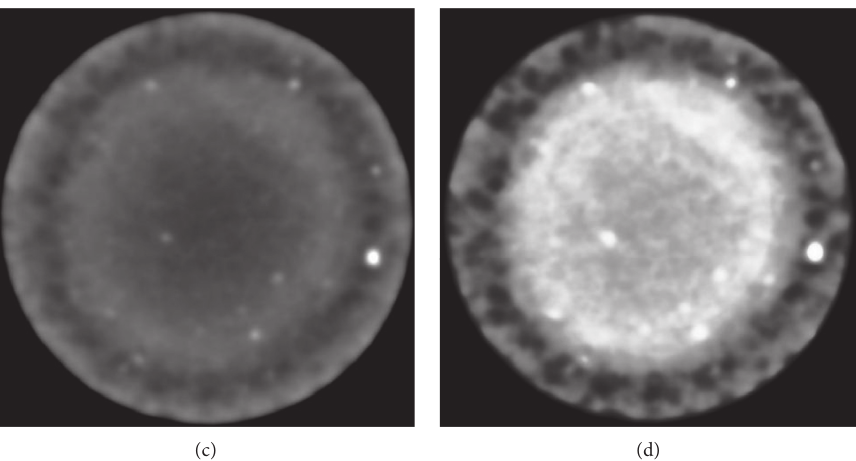
Figure 5: Two-dimensional CT image processing of acid-corroded sandstone. (a) Initial CT image in DICOM format. (b) Image cropping. (c) Image artifact reduction. (d) Image preprocessing.